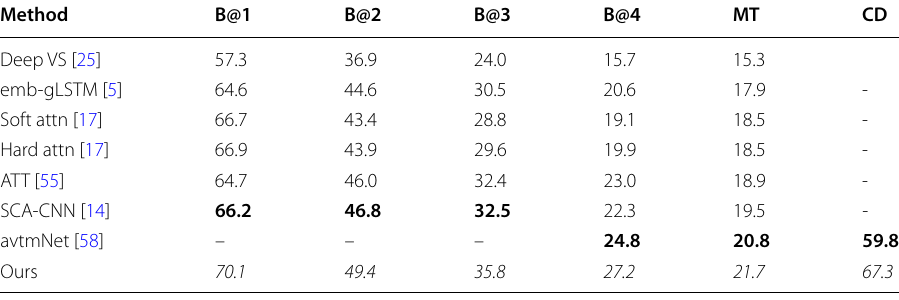
Table 6 Performance comparison of the proposed method on Flickr30K dataset. The best two models having larger values of the metrics are shown in red and green